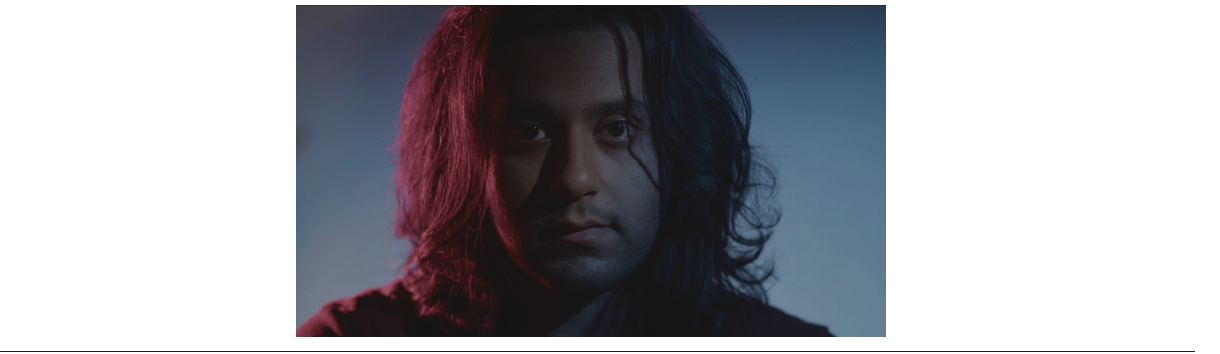
Figure 12. Close-up shot with anxious mood by Group 2 (Source: Author, 2022)